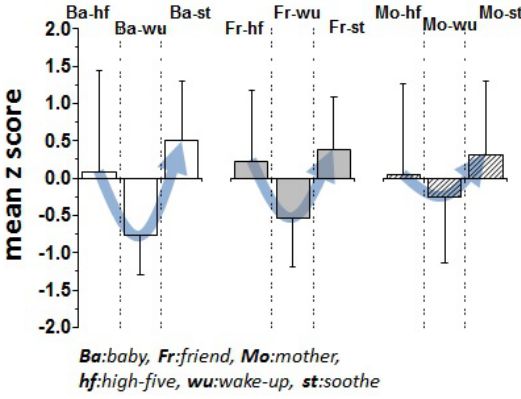
Fig. 10. Estimating the horizontal projection in the experiment with non-autistic children